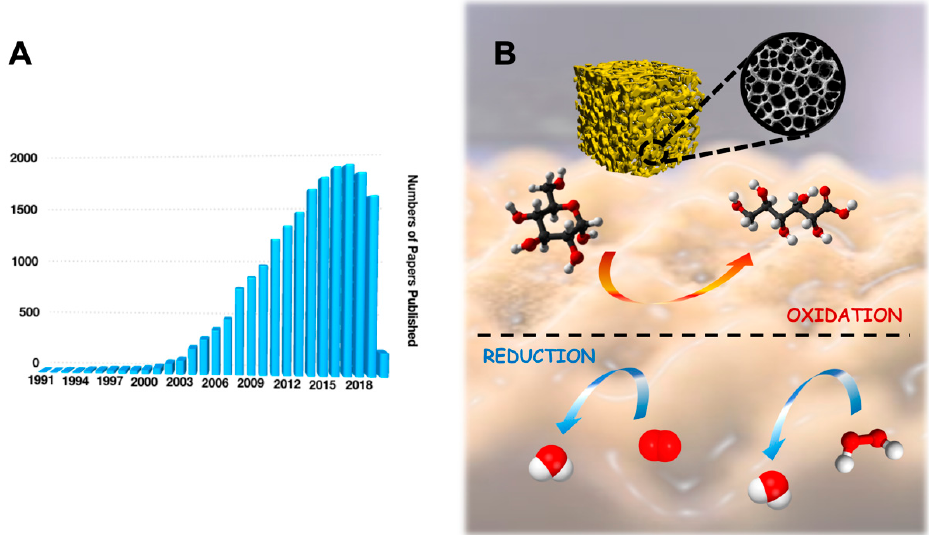
Figure 1. ( A ) Statistical data for number of papers published in the last 30 years by searching ‘gold nanostructures’ in Web of Science on 1 March 2020. ( B ) Porous gold structure that is able to catalyze a wide range of reactions at the electrode surface (e.g., glucose oxidation, oxygen reduction, hydrogen peroxide reduction,